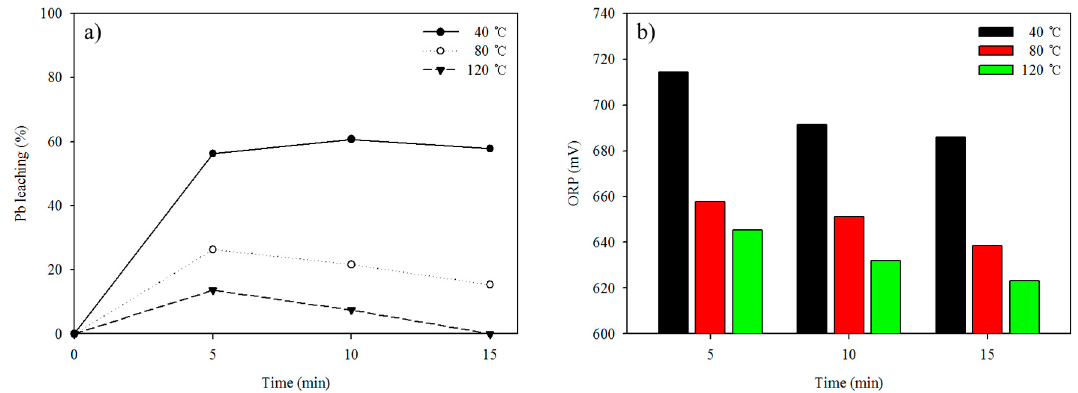
Figure 6. Effect of temperature on the leaching efficiencies of Pb ( a ) and ORP (mV) ( b ) from the refractory gold concentrate. The leaching conditions were an HNO 3 concentration of 1.0 M, reaction time of 15 min, and reaction temperatures of 40, 80, and 120 °C.